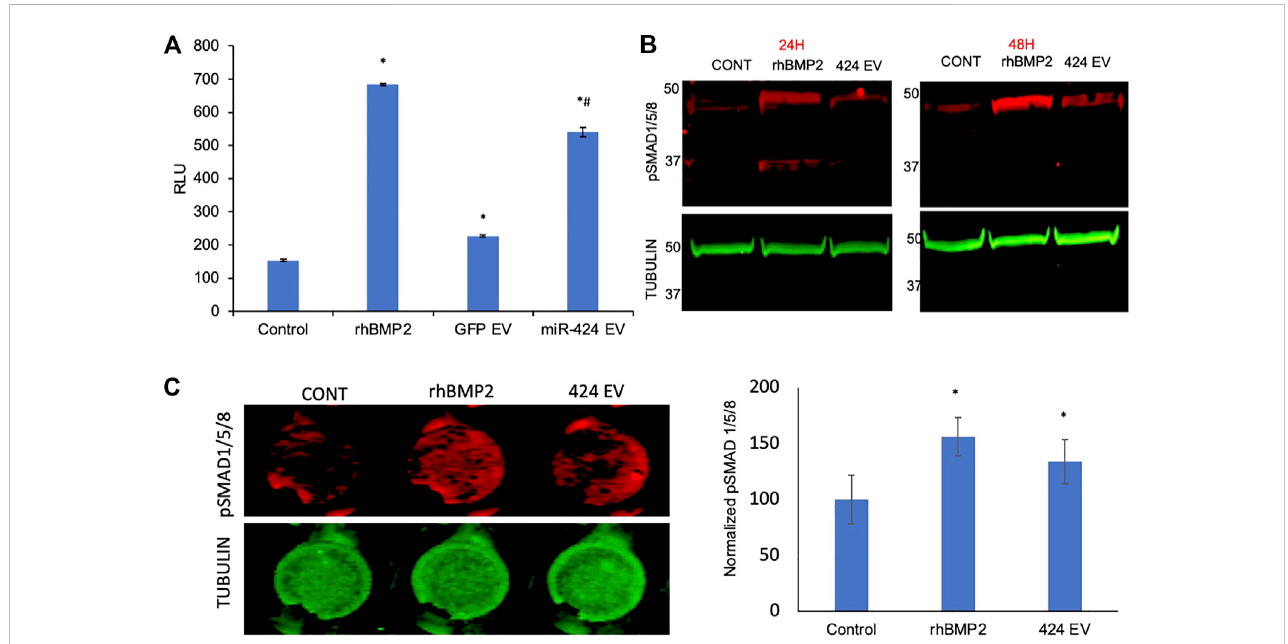
FIGURE 4 Engineered EVs trigger the BMP2 signaling cascade in vitro . (A) Graph representing luciferase activity in HMSCs transfected with a BMP2 reporter luciferase plasmid. Data are represented as mean luciferase activity (RLU, ± SD). Recombinant BMP2 protein (rhBMP2) was used as positive control. Note the signi fi cant increase in luciferase activity in 424 EV treated group compared to both untreated and vector controls. * represents statistical signi fi cance with respect to untreated control and # represents signi fi cance with respect to vector control (GFP EV) as measured by Tukey ’ s post hoc test following ANOVA. (B) Immunoblots showing the presence of phosphorylated SMAD 1/5/8 protein at 24 and 48 h after treatment with rhBMP2 (positive control) or 424 EVs. Tubulin was used a loading control. Note the increase in the presence of phosphorylated SMAD 1/5/8 in the 424 EV treated group compared to untreated controls. (C) quantitative in-cell western for the presence of phosphorylated SMAD 1/5/8. The image on the left is a representative image of pSMAD1/5/8 expression and the corresponding tubulin expression in a 96 well plate assay. The graph represents quantitation of the fl uorescence from the